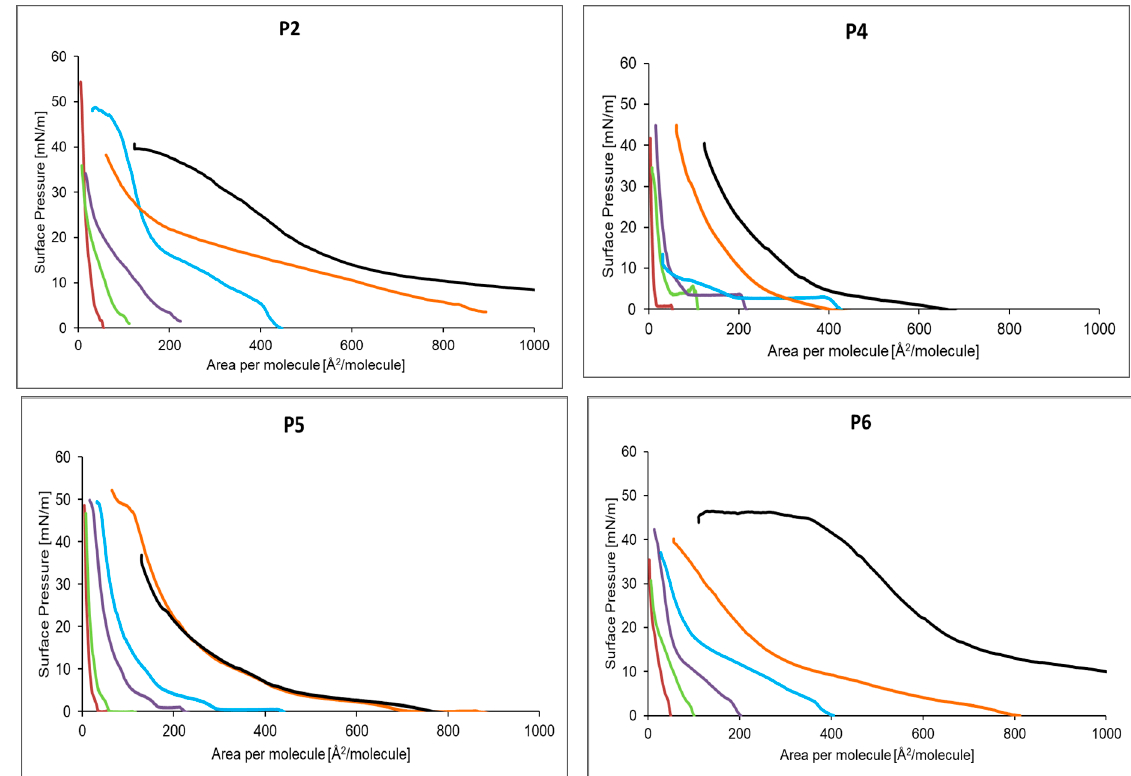
Figure 3. The compression isotherm of the P2, P4–P6 peptide monolayer formed on the surface of the pure liquid phase for the concentration of 1 (-), 2 (-), 3 (-), 4 (-), 5 (-), 6 (-).